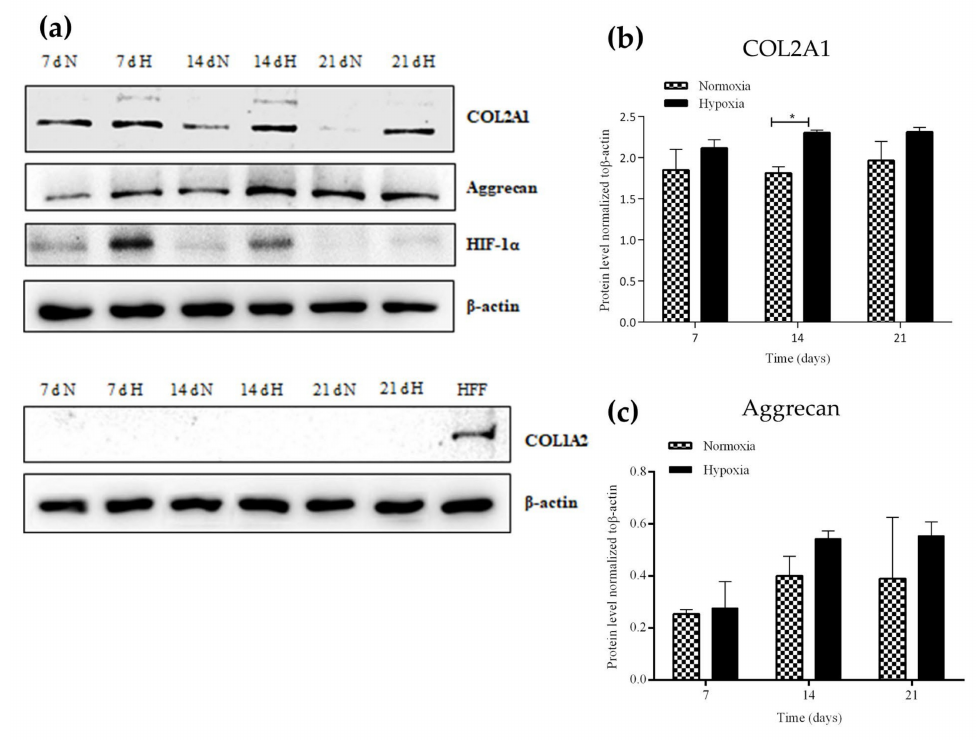
Figure 3. Analysis of ( a ) COL2A1, aggrecan, HIF-1 α and COL1A2 protein expression in the chondrospheroids by Western blot (n spheroids = 10). As an internal positive control for COL1A2 expression, a human foreskin fibroblast (HFF) cell line was used. ( b ) COL2A1 and ( c ) aggrecan quantifications were normalized to β -actin. N: normoxia (20% O 2 ); H: hypoxia (5% O 2 ); d: days. Two-way ANOVA and Bonferroni correction was performed for the statistical analysis (* p <